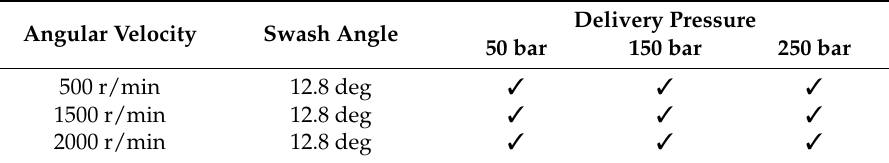
Table 1. Operating points considered for the acceleration acquisitions in healthy and faulty conditions. Angular